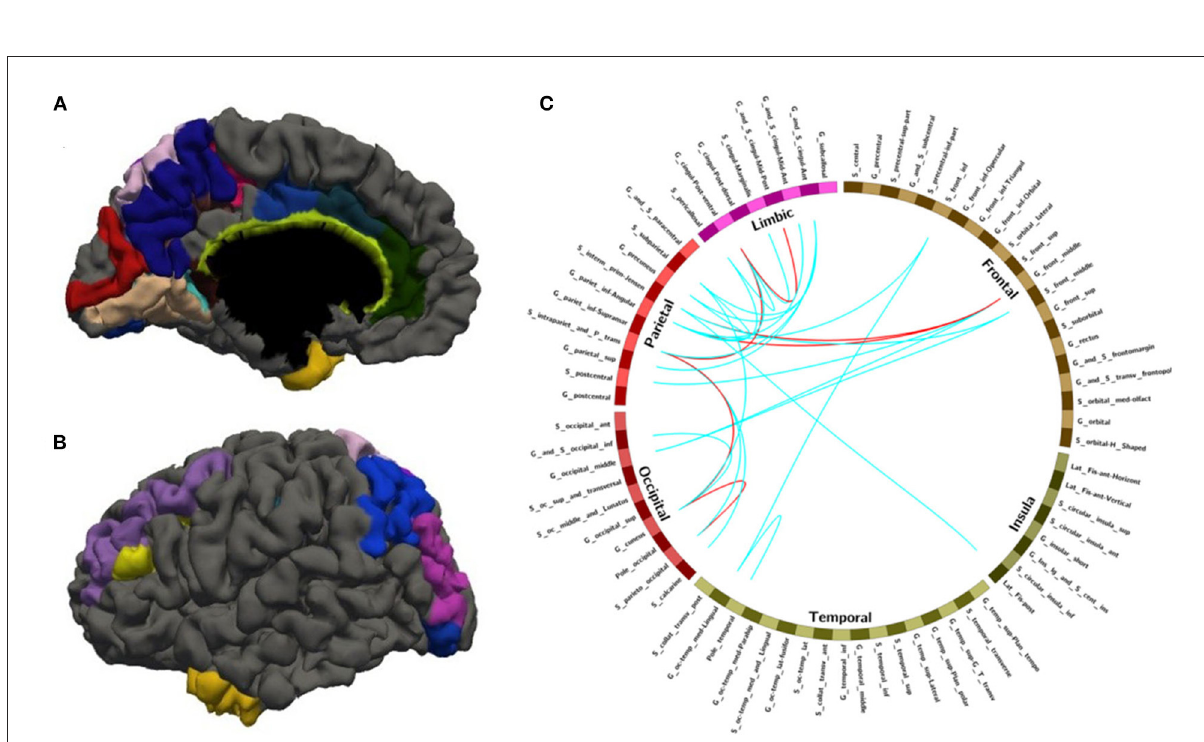
FIGURE3 The nodes and edges involved in the FC features with high overlap rate (12/14) among training. (A,B) Regions involved in 28 FC features with overlapping ratios ≥ 12/14 across 14 training sessions. (C) Edges involved in 28 FC features with overlap ratio ≥ 12/14 in 14 training